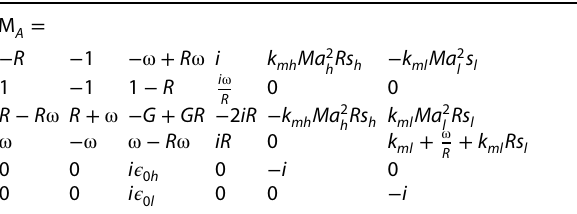
Table 3 The elements of the matrix defining solutions of the inter- facial boundary value problem for the advection